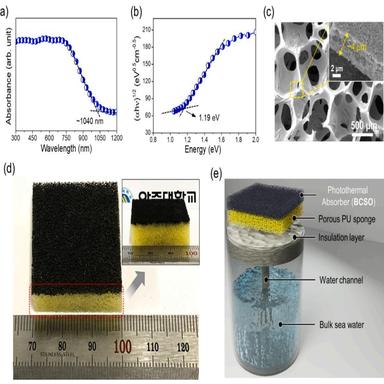
Optical property, microstructure analysis of BCSO 160 coated PU sponge substrate, and solar steam generation setup: (a) Absorbance spectrum, (b) Tauc plot (for band gap determination), (c) Top-view SEM images of photothermal absorber (Inset shows the thickness of BCSO layer coated on PU sponge), (d) Photograph of BCSO nanosheets coated with PU sponge substrate (top view (left) and side view (right)), and (e) Schematic of the solar steam generation setup.